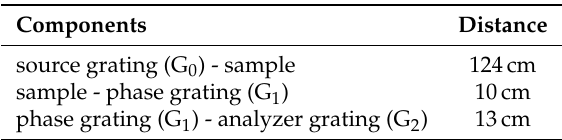
Table 1. Distances between the components.